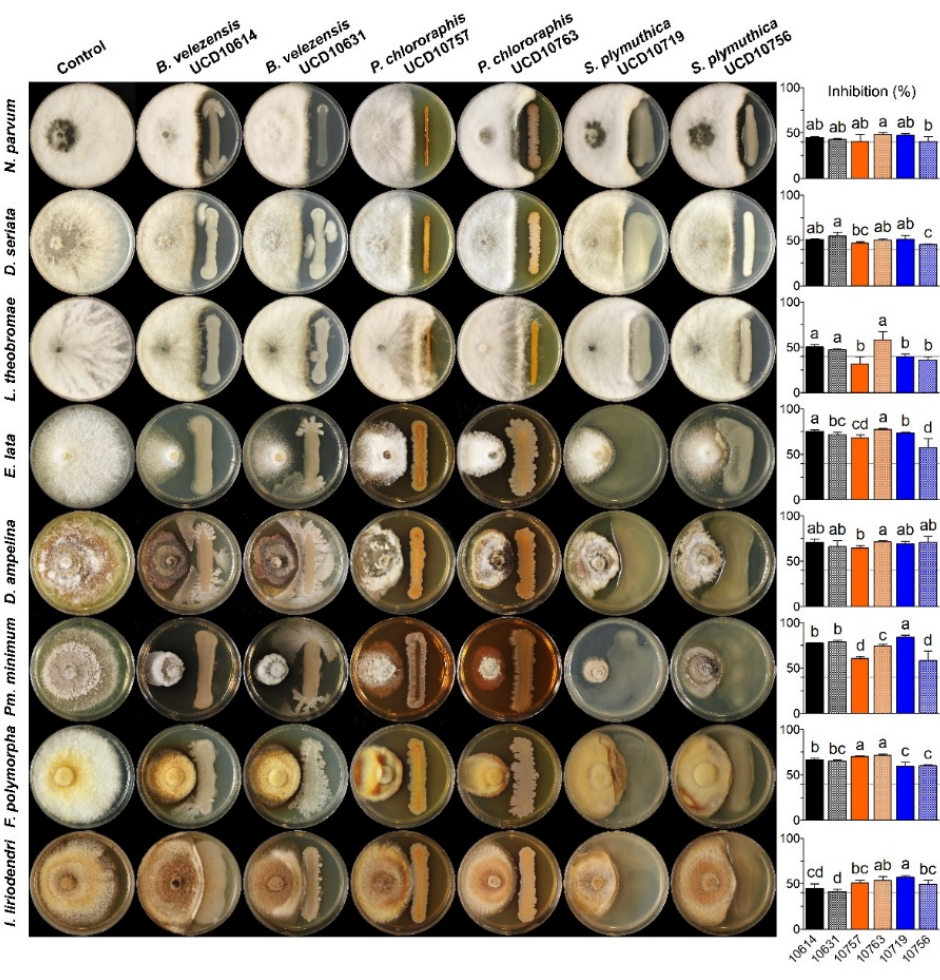
Figure 6. Inhibition levels (%) caused by selected isolates of B. velezensis , P. chlororaphis and S. plymuthica against Neofusicoccum parvum , Diplodia seriata , Lasiodiplodia theobromae , Eutypa lata , Diaporthe ampelina , Phaeoacremonium minimum , Fomitiporia polymorpha , and Ilyonectria liriodendri . Means with the same letter horizontally on each graph are not significantly different from each other according to the Fisher’s LSD test ( p > 0.05). Gray line represents the threshold of 40% of